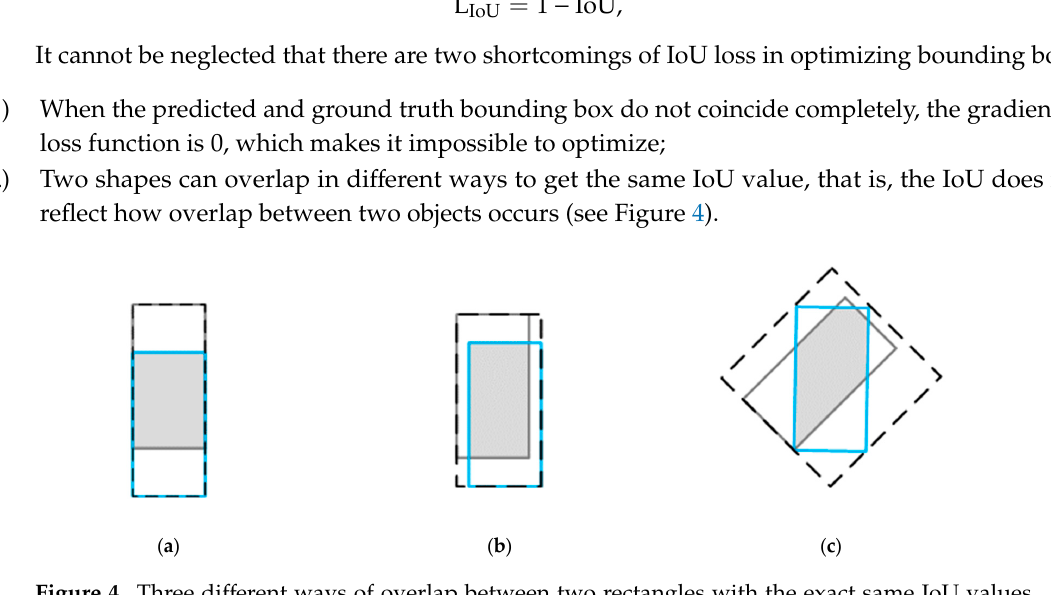
Figure 4. Three different ways of overlap between two rectangles with the exact same IoU values, (i.e., IoU = 0.50), but different GIoU values (i.e., from the left to right GIoU = 0.50, 0.45, and 0.09, respectively). For the case with better aligned orientation, the GIoU value will be higher.